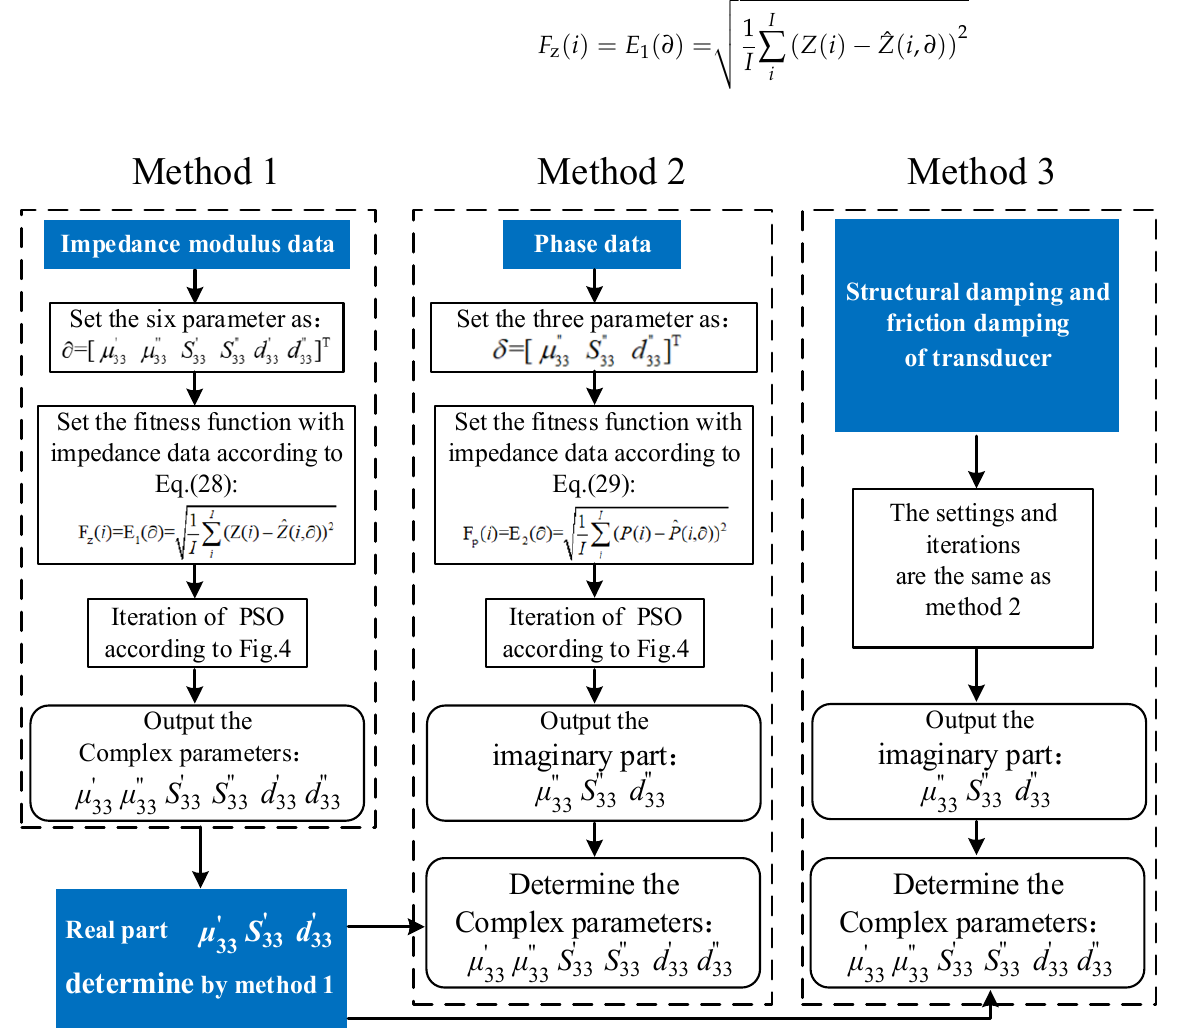
Figure 5. Flowchart of three methods of parameters characterization.